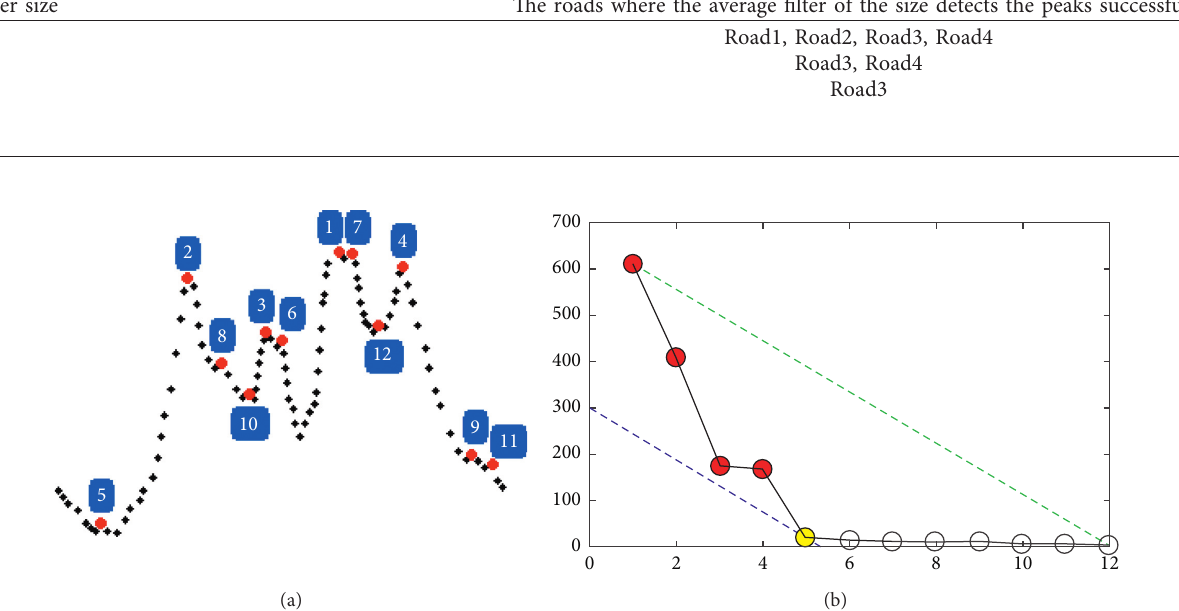
Figure 6: (a) The candidate peak points of the data in Figure 4, each labeled by its number in the sorted prominences. (b) The sorted prominences in dots, where the x -axis represents the ordinal number, the y -axis represents the prominence, the green dash line connects the first and last dots, the blue dash line is a tangent line parallel to the green line, the yellow dot is the bending dot, and the 4 red dots correspond to the 4 peak points